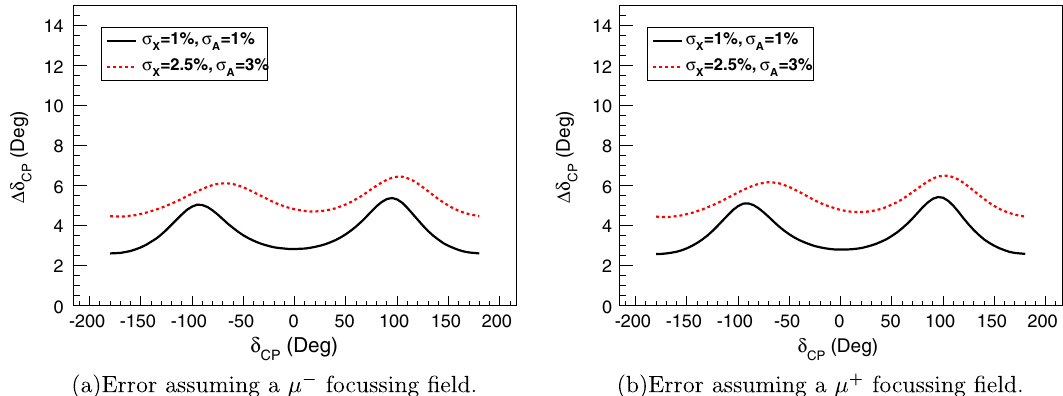
FIG. 12. Uncertainty on (cid:2) CP as a function of (cid:2) CP for the two possible detector field polarities. The black line assumes the 1% systematic uncertainties that are believed will be prevalent at the neutrino factory, while the red line assumes uncertainties inflated by a factor of between 2.5 and 3.